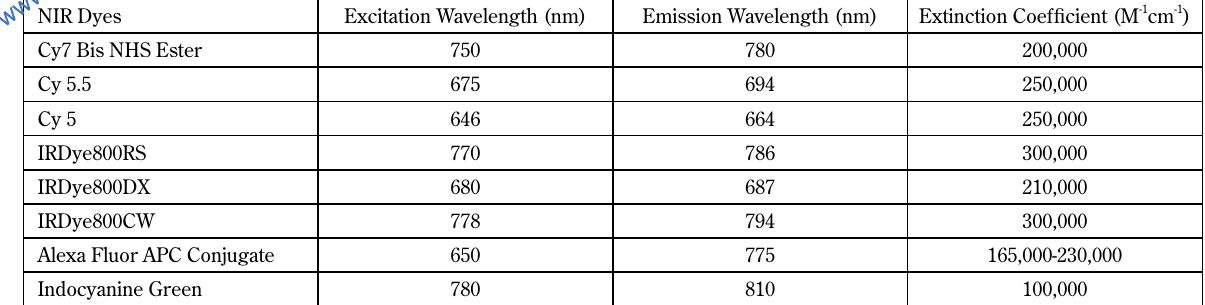
Table 2 Commonly used and commercially available near-infrared dyes, their excitation and emission maxima and